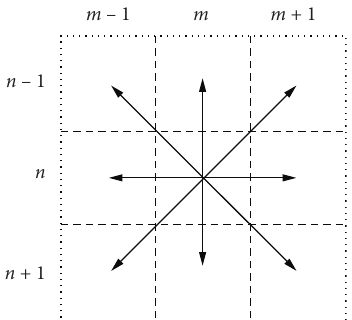
Figure 4: Schematic of velocity gradient for discrete data.